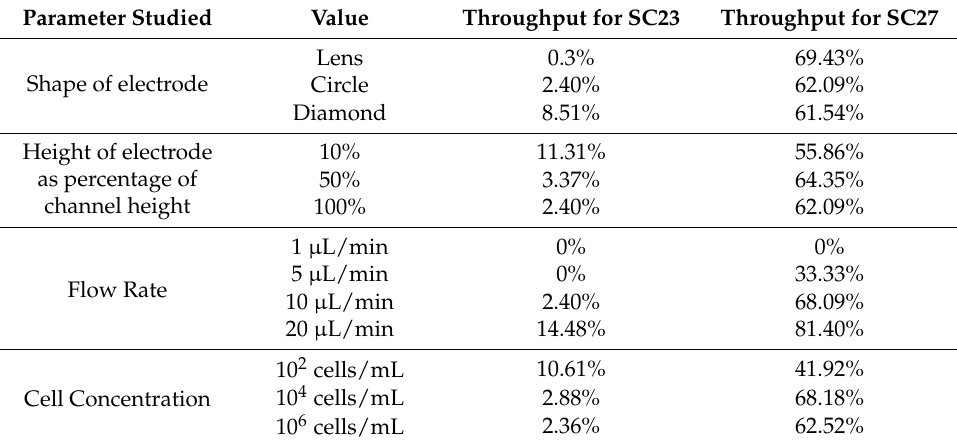
Table 1. The average percentage throughput in each of the cases in the simulation for SC23 and SC27 streams calculated using Equation (13). The throughput represents the percentage of total incoming streams of each type that are present in the streams after the electrode array. Since most of the SC23 streams show positive dielectrophoresis (DEP) and get captured at the electrodes, the throughput for this case is generally low. SC27 cells show negative DEP, no significant trapping and thus a high throughput is obtained. Parameter Studied